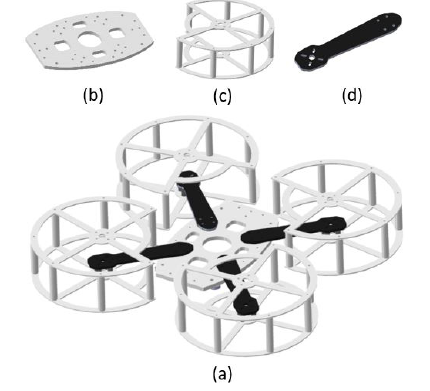
Figure 5. ( a ) CAD model of quadcopter structure assembly. ( b ) Center plate. ( c ) Propeller protector. ( d )